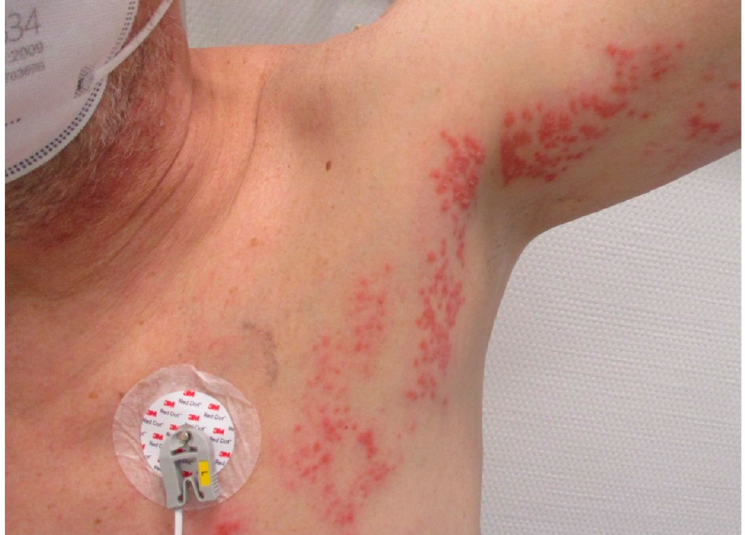
Figure 1. Herpes zoster infection, pathognomonic clinical appearance.